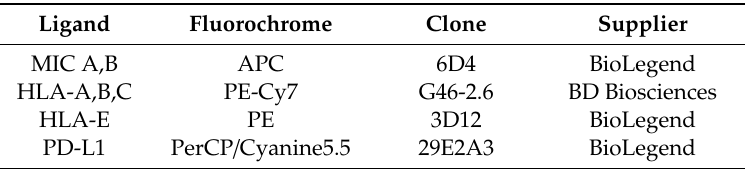
Table 1. Antibodies used in this